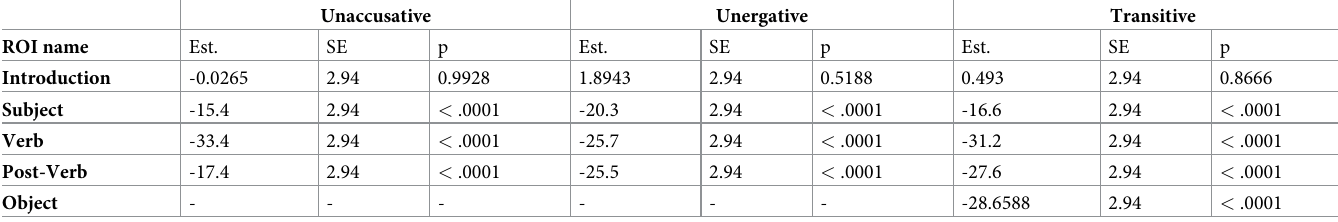
Table 2. Pairwise comparisons of gaze fixations to the target by ROI and verb